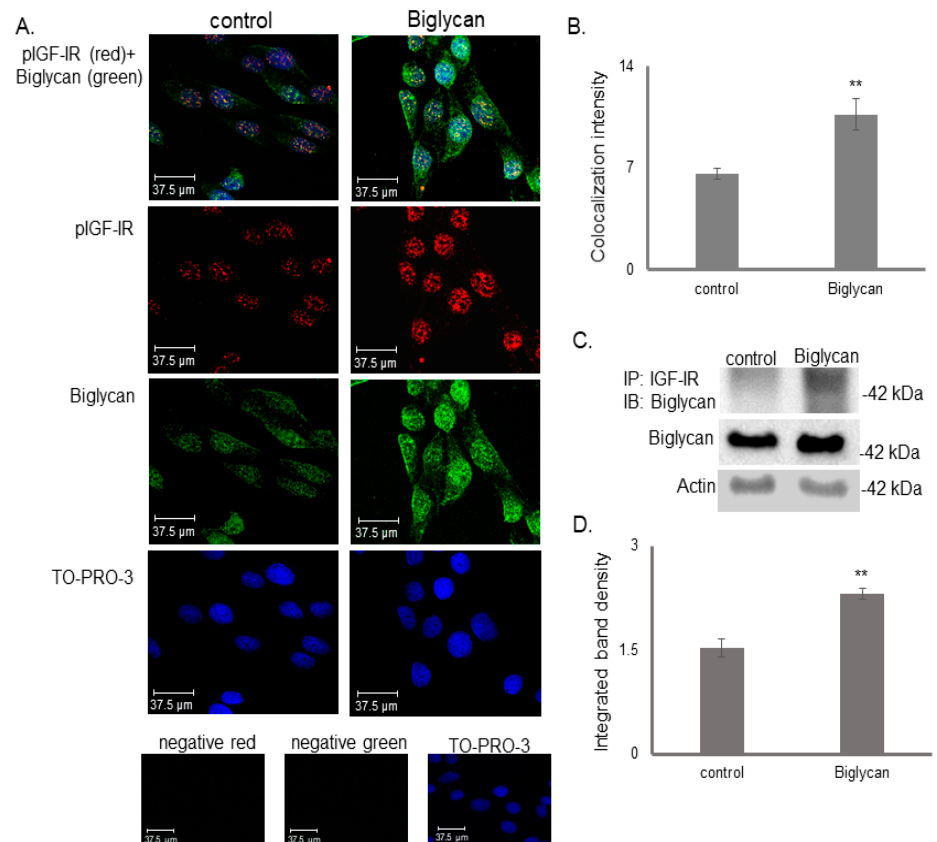
Figure 1. Co-localization of biglycan and pIGF-IR in MG63 cells. ( A ) Biglycan (green; anti-rabbit Alexa Fluor 488) and pIGF-IR (red; anti-mouse Alexa Fluor 555) protein staining of cells and respec- tive nuclear staining (using TO-PRO-3) were evaluated in cultures after 48 h in serum-free medium (control) or biglycan (10 μ g/mL). Primary antibodies were omitted in negative controls, but both secondary antibodies were used (anti-mouse—negative red; anti-rabbit—negative green). Slides were analyzed by confocal microscopy and pictures were taken using × 40 magnification. ( B ) Intensity measurement of co-localization of biglycan and pIGF-IR in MG63 cells was calculated using ImageJ Analysis Software. Representative pictures are presented. ( C ) Control cells were treated with serum-free culture medium, and samples were treated for 48 with biglycan (10 μ g/mL). Cells ex- tracts were incubated with IGF-IR antibody overnight in a rotating platform, and IGF-IR complexes were immunoprecipitated with Protein A/G. Western blot analysis was used to visualize biglycan protein immunoprecipitation with IGF-IR. ( D ) Densitometric analysis of the bands of immunopre- cipitated proteins was normalized against the total expression of each protein in the cells and plot- ted. Representative pictures are presented. The results represent the average of three separate ex- periments. Means ± S.E.M. plotted; statistical significance is as follows: ** p ≤ 0.01, compared with the respective control samples.